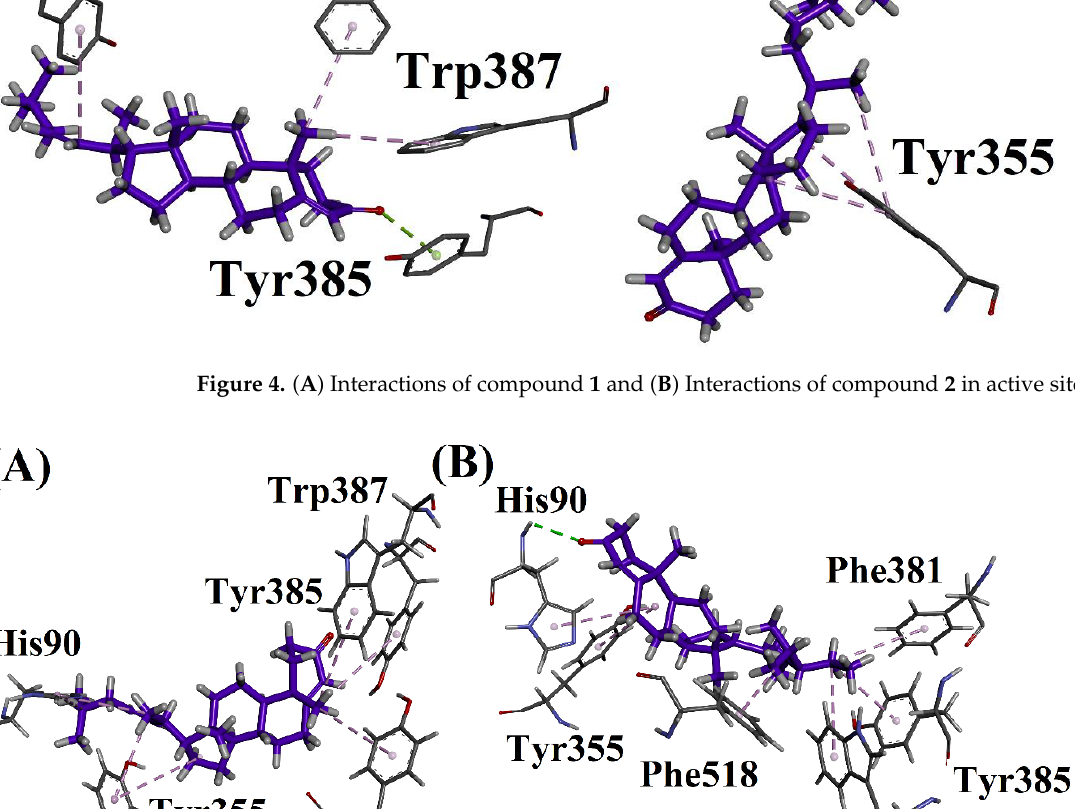
Figure 5. ( A ) Interactions of compound 1 and ( B ) Interactions of compound 2 in COX-2 active site.